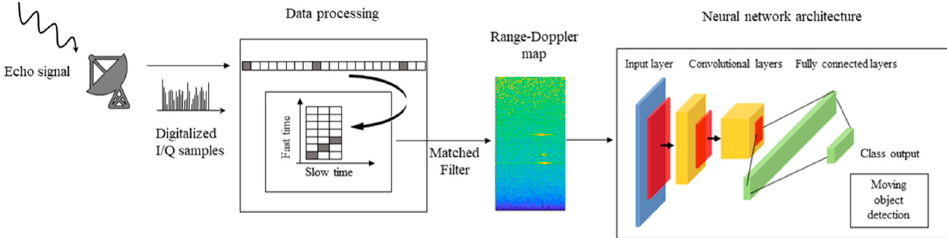
Figure 4. Flowchart of the experimental evaluation presented in this paper.